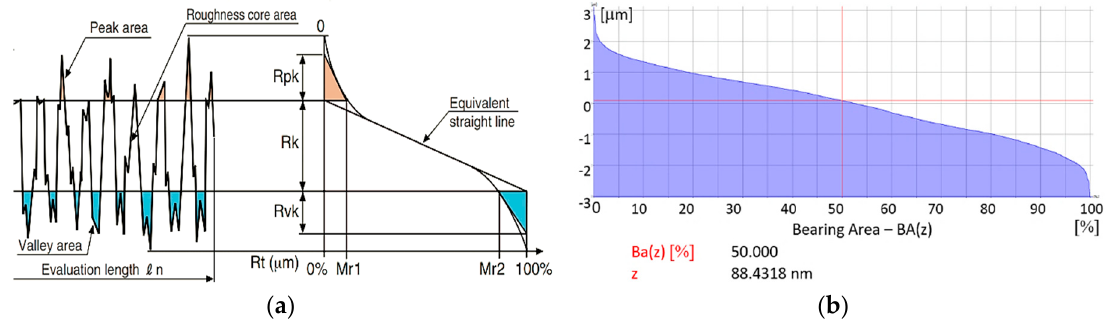
Figure 20. Abbott-Firestone’s curves, ( a ) construction according to the standard ISO13565-2:1996; ( b ) AFC obtained by means of software belonging to the Mahr MarSurf M300 device for sample No. 55.